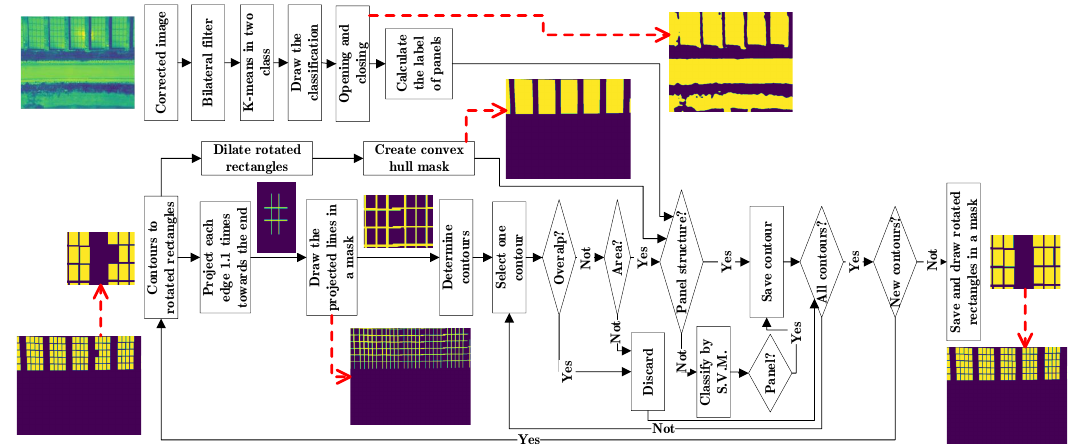
Figure 7. Projection of the edges of the rotated rectangle, determination of new contours and their